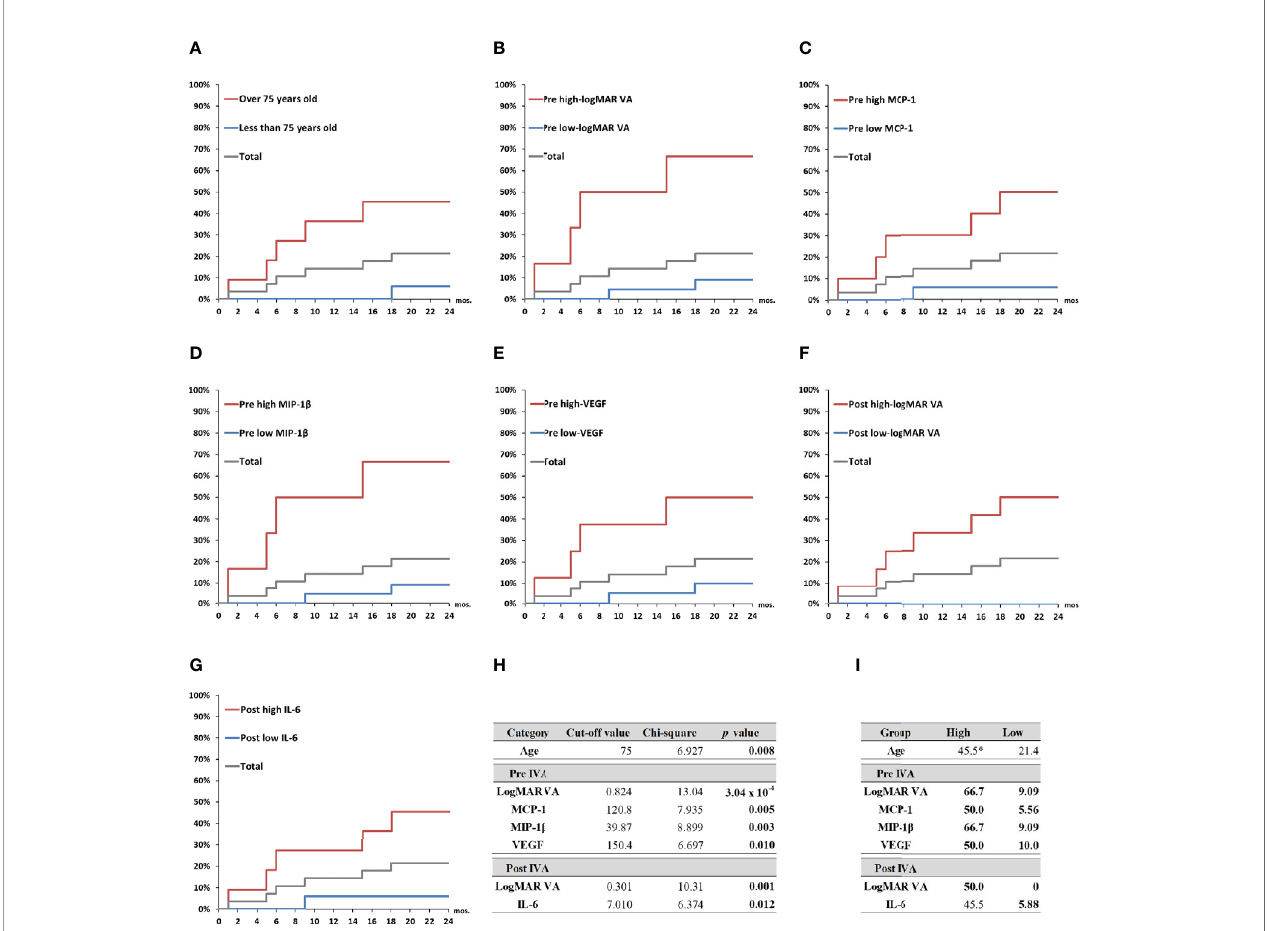
FIGURE 5 | Probability of incidence of macular atrophy depending on age, visual acuity, and aqueous humor cytokine levels in nAMD eyes under a fl ibercept treatment. Kaplan – Meier survival curves were used to estimate the probability of MA incidence in nAMD eyes under IVA treatment for 2 years. The nAMD group was divided by cutoff values: (A) age over or under 75 years at baseline, (B) pre-IVA logMAR VA higher or lower than 0.824, (C) pre-IVA level of MCP-1 higher or lower than 120.8 pg/ml, (D) pre-IVA level of MIP-1 b higher or lower than 39.9 pg/ml, (E) pre-IVA level of VEGF higher or lower than 150.4 pg/ml, (F) post-IVA logMAR VA higher or lower than 0.301, and (G) post-IVA level of IL-6 higher or lower than 7.01 pg/ml. (H) Values of chi-square and p between high-value and low-value groups divided by each cutoff value. (I) Rates of MA incidence in high-value and low-value groups divided by each cutoff value. *percentage; IL, interleukin; IVA, intravitreal injection of a fl ibercept; MA, macular atrophy; logMAR, logarithm of the minimum angle of resolution; MCP-1, monocyte chemotactic protein-1; MIP-1 b , macrophage in fl ammatory protein; mon., month; nAMD, neovascular age-related macular degeneration; VA, visual acuity; VEGF, vascular endothelial growth